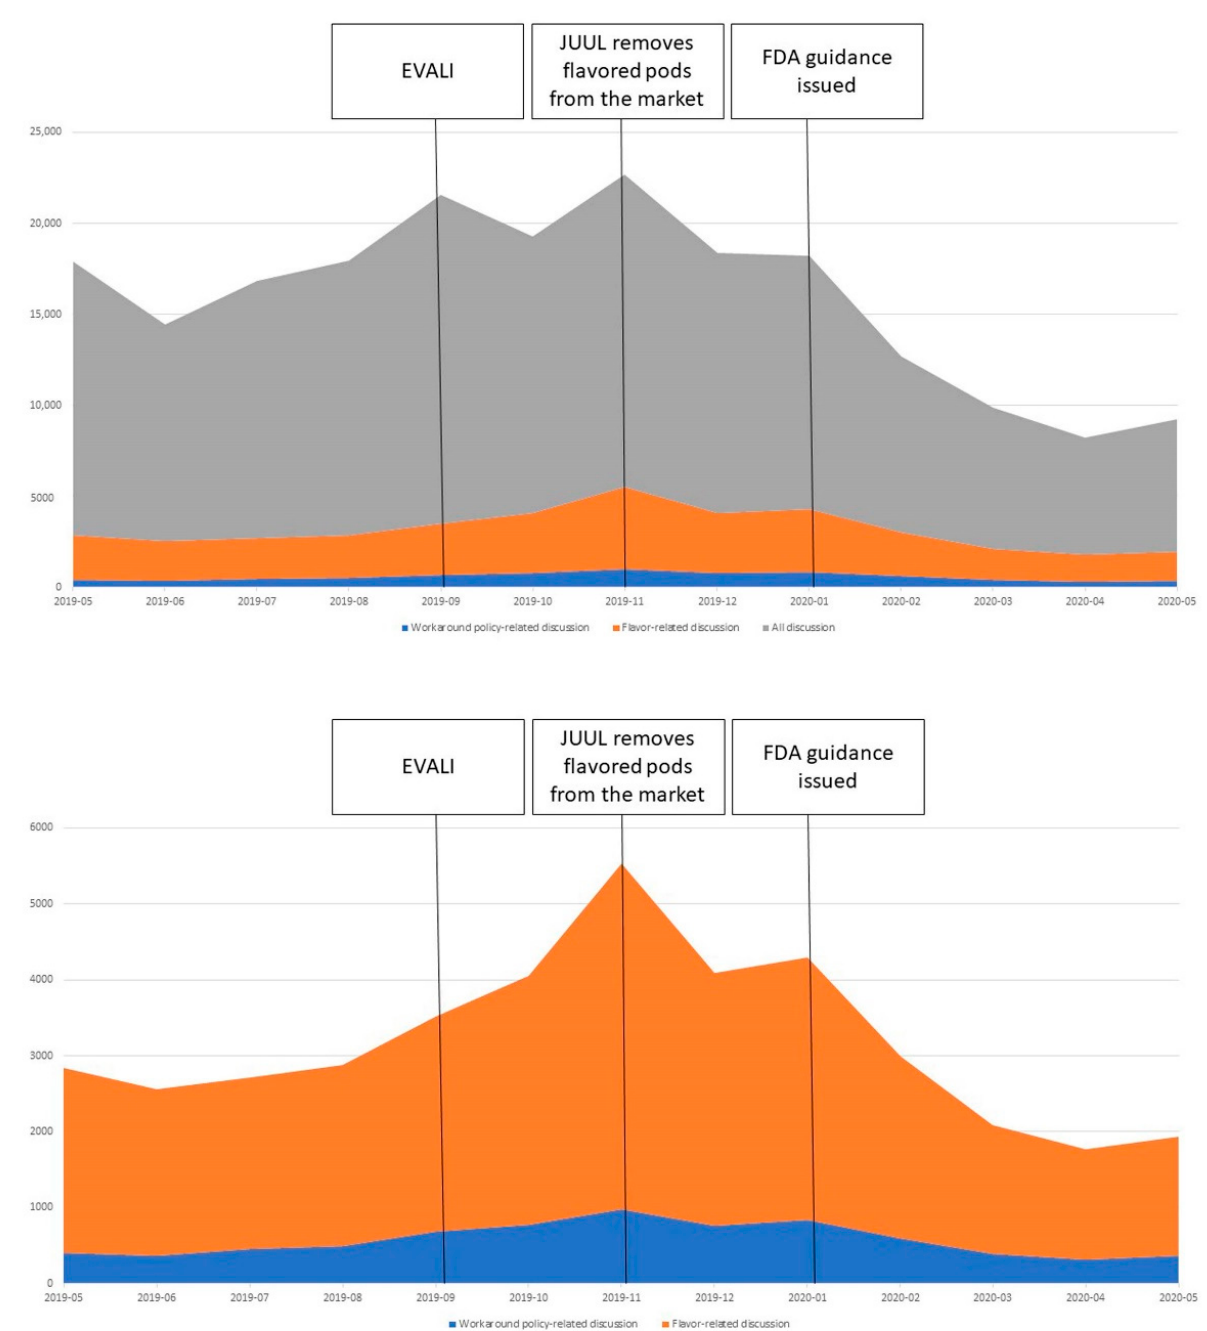
Figure 1. Temporal graphs comparing trends of the volume of activity on r/JUUL related to flavors and strategies to evade flavored product restrictions as well as all activity on the subreddit. ( Top ) FTP policy workaround discussion (blue) as a portion of flavor discussion (orange) as a portion of all activity on the subreddit (gray). ( Bottom ) The all activity (gray) portion is removed to better visualize the variation in FTP policy workaround discussion (blue) as a portion of all flavor-related discussion (orange).